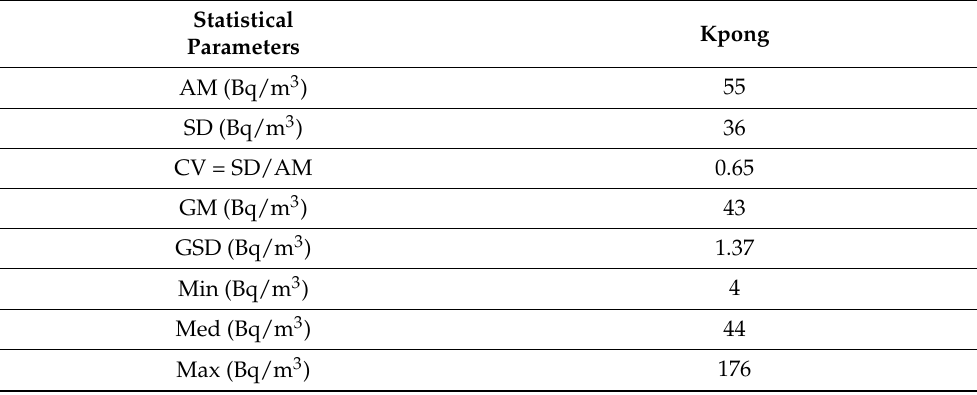
Table 1. Statistical parameters (arithmetic mean (AM), the geometric mean (GM), the standard de- viation (SD), the coefficient of variation (CV), the geometric standard deviation (GSD), the minimum (Min), the median (Med) and the maximum (Max)) for the total measurements on the Kpong.